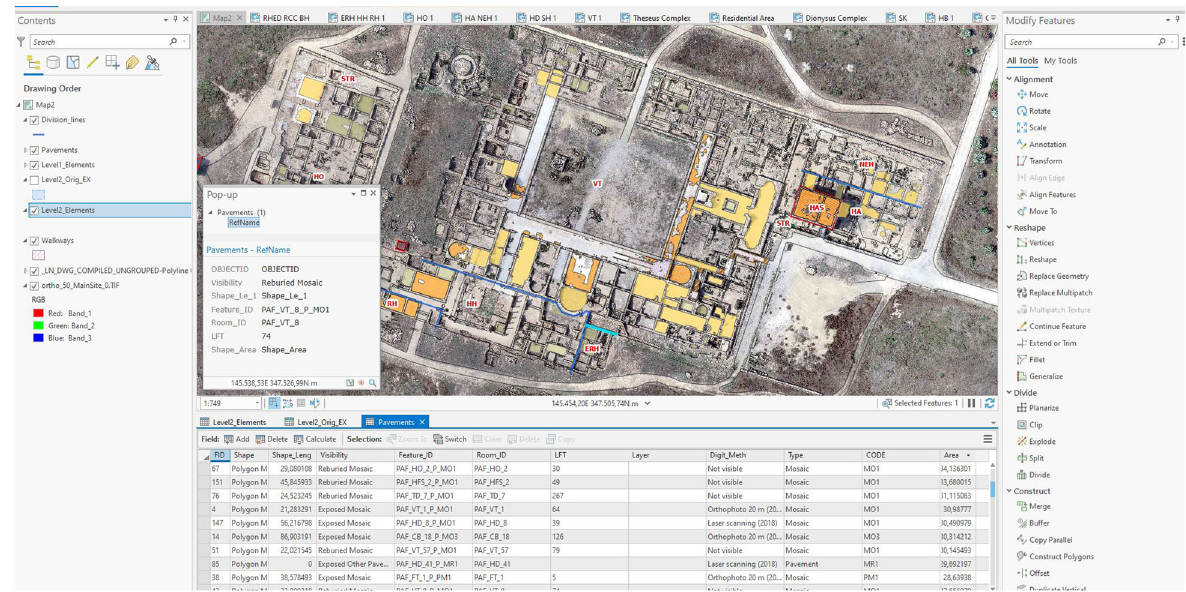
Fig. 15 Screenshot of the GIS showing attributes of exposed mosaics in their archaeological context (Source: the